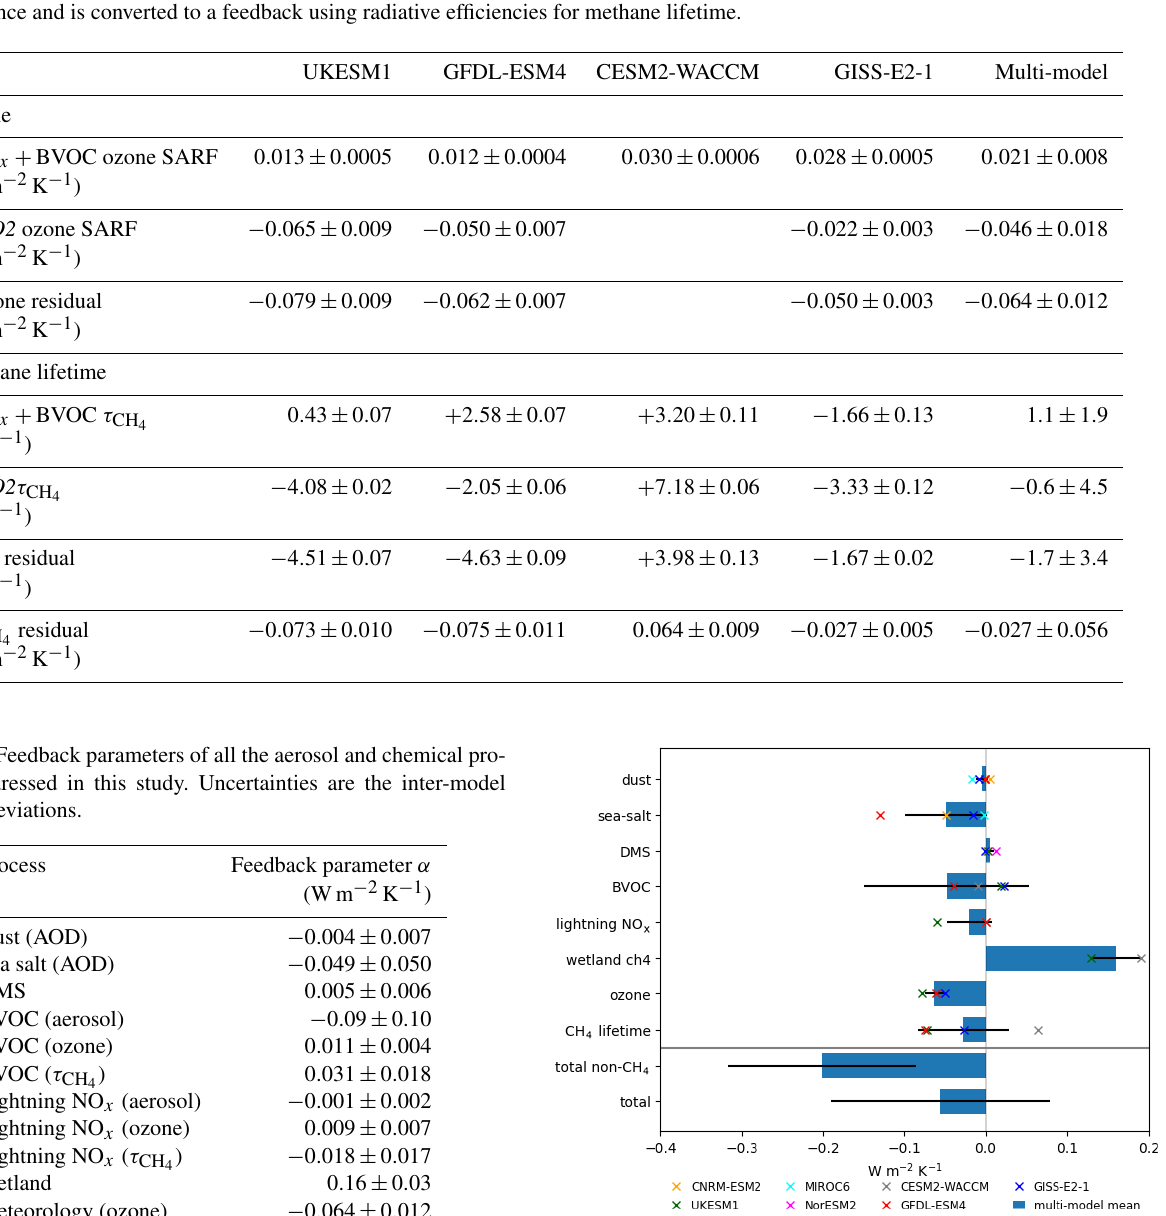
Figure 5. Feedback parameters of all the aerosol and chemical processes in Table 15. Multi-model mean and individual models are shown. Uncertainties are the inter-model standard deviations. BVOC and lightning are the sum of aerosol, ozone and methane lifetime effects (points are only shown for models that include all effects). Ozone and CH 4 lifetime are the chemical effects (i.e. ex- cluding BVOC and lightning emissions). Non-CH 4 is the sum and excludes methane lifetime effects and wetland